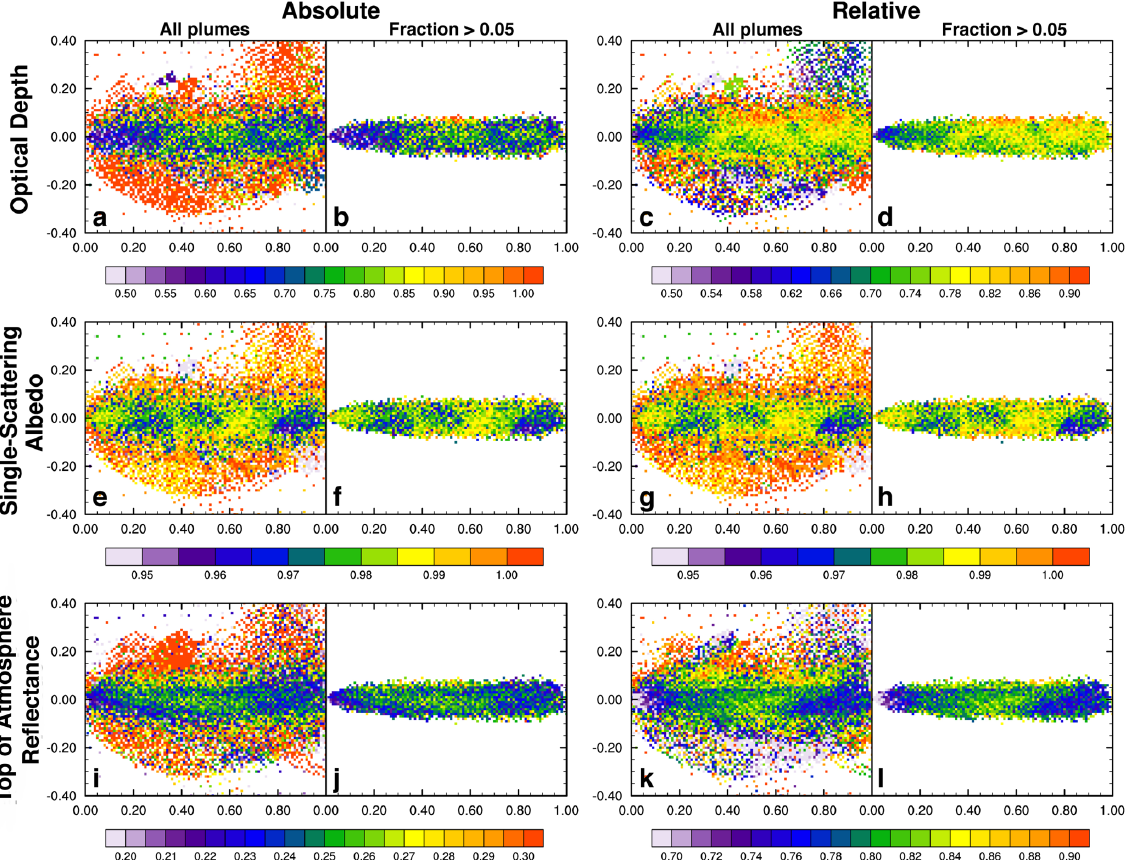
Fig. 6. Absolute and relative optical properties of all plumes and of the mean plume (fraction > 0.05). (a, b) Absolute optical depth. (c, d) Relative optical depth. (e, f) Absolute single-scattering albedo. (g, h) Relative single-scattering albedo. (i,j) Absolute top-of-atmosphere reflectance. (k, l) Relative top-of-atmosphere reflectance. Within each pair of graphs, values are identical; graphs on the left show all points while graphs on the right show only the mean plume. Colors represent the average of the given optical property at that point.